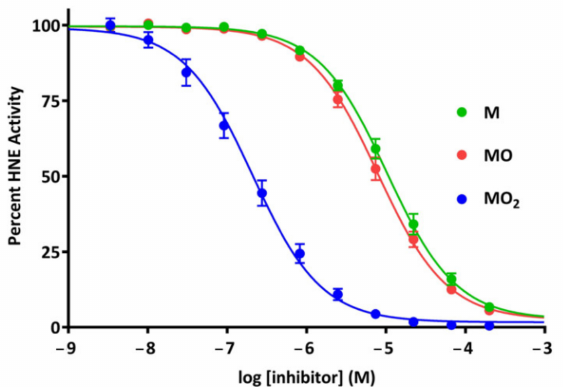
Figure 3. Dose-response plot of Ac-RMAV-H peptide aldehyde inhibitor variants containing differing oxidation states of the P3 methionine residue. All assays contained 10 nM active HNE and 100 nM Ac- RM(O 2 )AA-pNA substrate. Data are reported as percent activity remaining compared to uninhibited controls, and data points represent the mean observed from three replicate experiments of triplicate measurements. Error bars show SEM. Where not visible, error bars are smaller than the pictured data point.